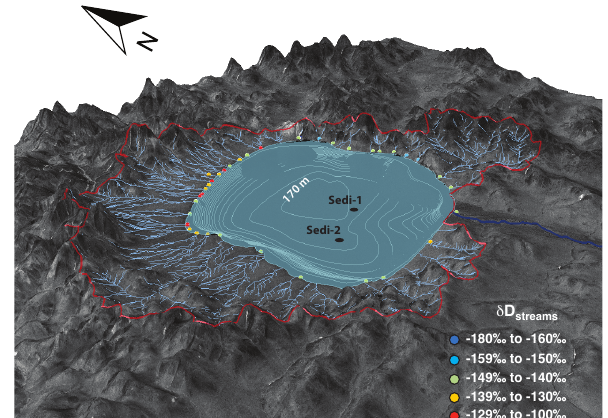
Fig. 2. Location of the sediment traps deployed in Lake El’gygytgyn in 2003, streams and the δ D of sampled stream water. View to the NE with 5x vertical exaggeration. Coloured dots indicate measured δ D of stream waters collected in summer 2003. Red line denotes watershed; streams are indicated in light blue lines. Contours indi- cate lake